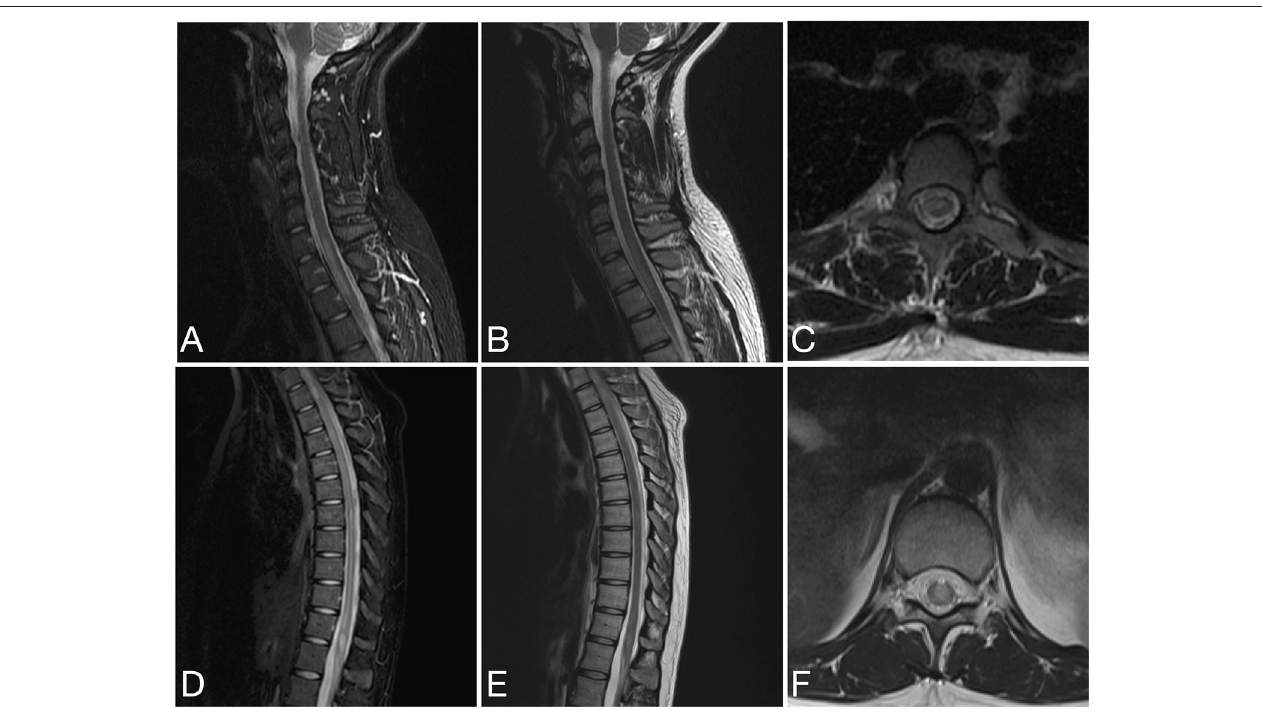
FIGURE 7 | Sagittal STIR (A) , sagittal T2 (B) and axial T2 (C) images of the cervical spine and sagittal STIR (D) , sagittal T2 (E) , and axial T2 (F) images of the thoracic spine from the same patient as in Figure 6 at the time of disease presentation. (A–C) A short segment T2/STIR hyperintense lesion (2 contiguous vertebral segments) involve the spinal cord at the cervicothoracic junction. (D–F) Other short segment T2/STIR hyperintense lesions involve the thoracic spinal cord and conus medullaris.